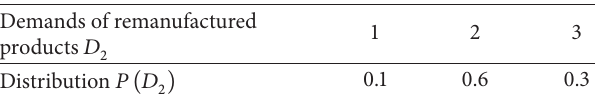
Table 4: The distribution of the demands of remanufactured products in stage